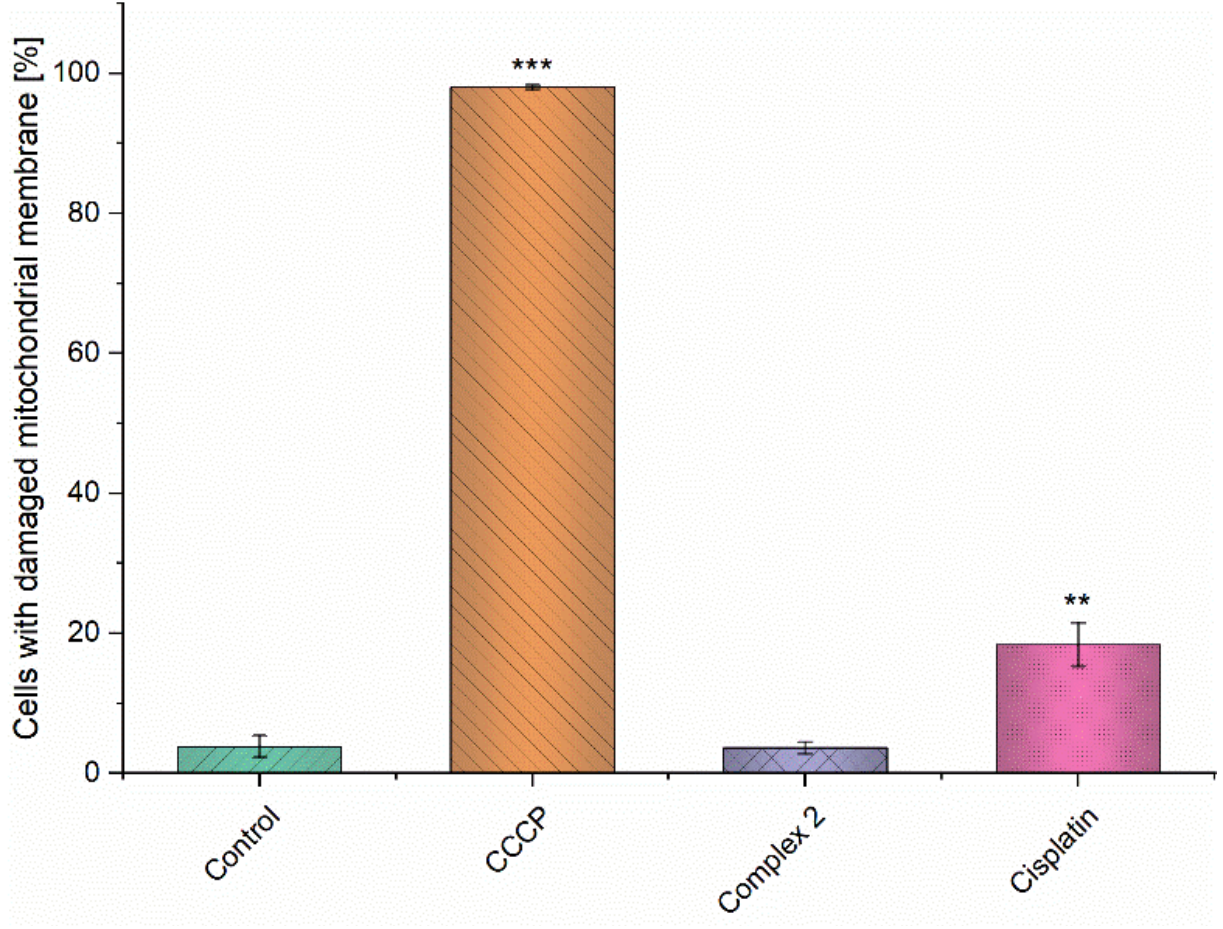
Figure 8. Effect of complex 2 (at 3 µ M), reference drug cisplatin (at 19 µ M), and the well-known inhibitor of mitochondrial oxidative phosphorylation carbonyl cyanide m -chlorophenyl hydrazone CCCP (100 µ M) on the mitochondrial membrane potential disruption in A2780 cells after 24 h of incubation. *** indicates statistical significance at the p < 0.005 level and ** p < 0.01 levels compared to the control.